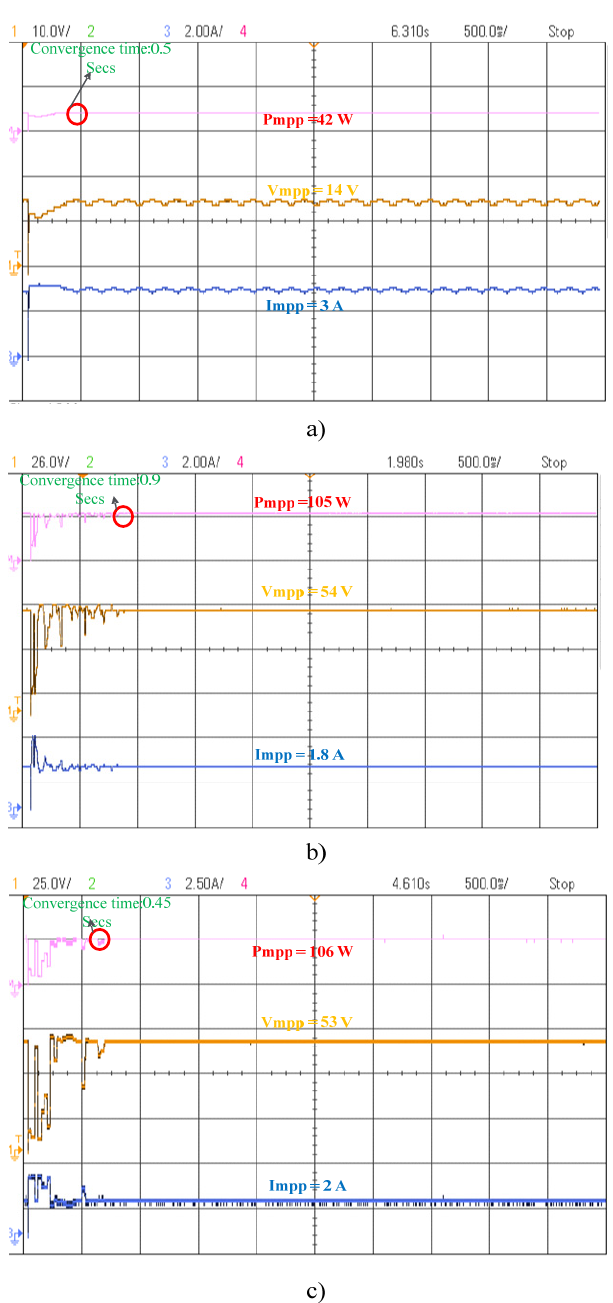
Figure 21. Experimental result for Pattern 5 under partial shading ( a ) P&O, ( b ) PSO, ( c ) SHO. 4.4.4. Hardware Experimental Result: Pattern 06 (6S1P: MPPT under Partial Shading—6